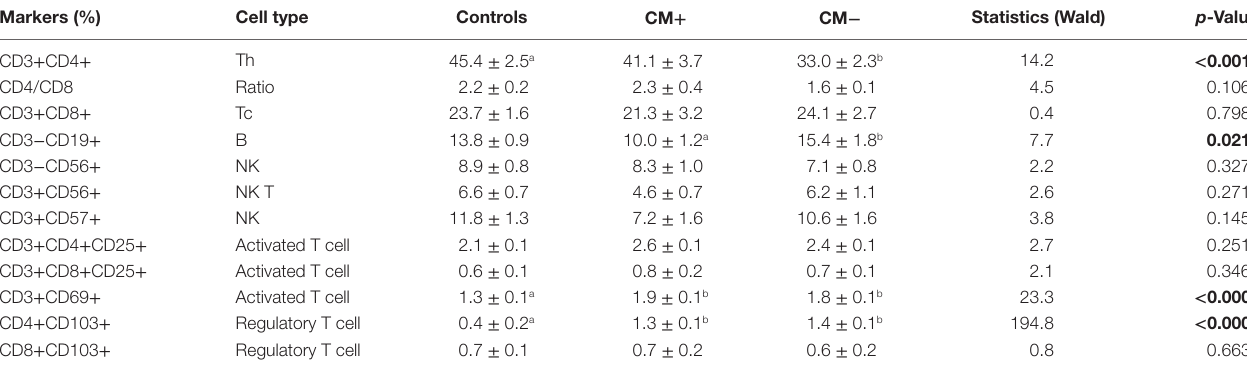
TaBle 2 | Immunophenotyping of major lymphocyte